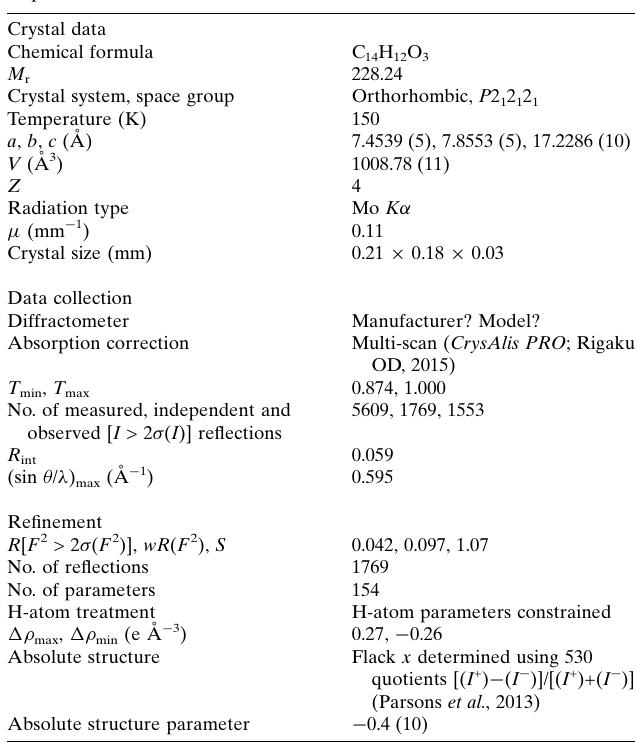
Crystal data Chemical formula